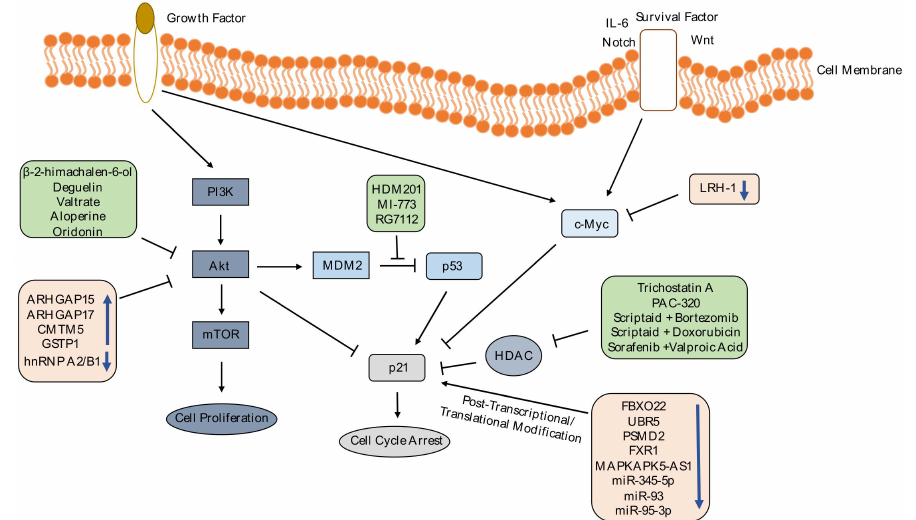
Figure 1. p21 expression induction through PI3K-Akt and c-Myc pathways. In this figure, drugs are shown in green boxes and di ff erentially expressed genes / miRNAs are shown in pink boxes. These di ff erentially expressed genes / miRNAs and drugs positively regulate p21 expression through reducing Akt phosphorylation, inhibiting MDM2-p53 interaction, suppressing c-Myc expression, preventing p21 ubiquitylation, preventing p21 mRNA destabilization, blocking negative regulation of p21 protein, or suppressing histone deacetylation. As a conclusion, increased p21 expression induces cell cycle arrest and decreases cell viability. PI3K: Phosphoinositide 3-Kinase, Akt: Protein